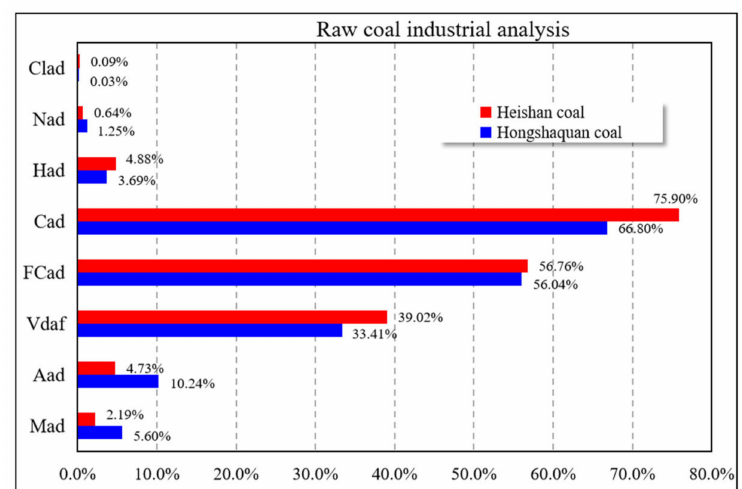
Figure 4. Raw coal industrial analysis (note: ad means air dry; Cl is chlorine; N is nitrogen; H is hydrogen; C is carbon; FC is fixed carbon; V is volatile; A is ash; M is moisture; the figure does not contain the characteristics of the two coal char residues which are both 2, the arsenic ( ω (Asad)) of Hongshaquan coal sample is 1 µ g/g, and that of Heishan coal sample is 3 µ